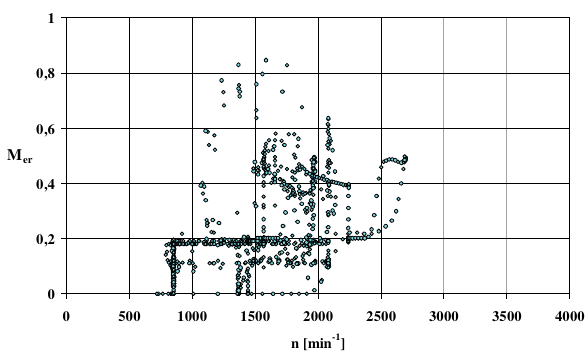
Fig. 11. Coefficient of variation of rotational speed in NEDC, Malta and RDE tests